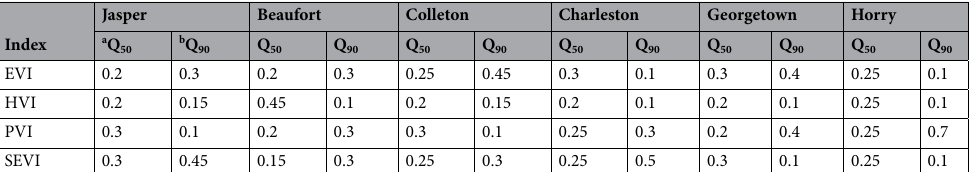
Table 5. List of weights of the vulnerability groups for 50th and 90th percentile CVI. a 50th percentile of weight in sensitivity analysis. b 90th percentile of weight in sensitivity